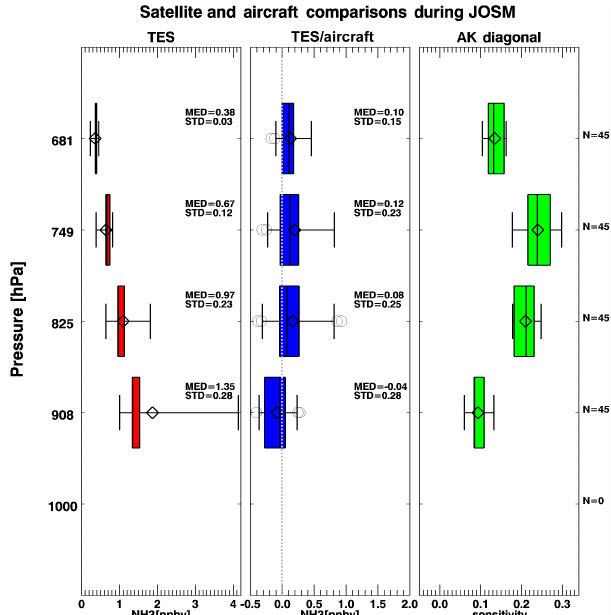
Figure 10. Summary box-and-whisker plots of the satellite and air- craft comparisons during JOSM flight 20 for NH 3 . All the available TES pixels from along the TES transect were included using the same plotting convention as Fig.